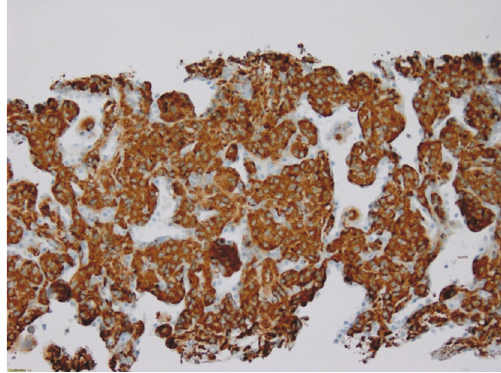
Figure 3: Neuroendocrine lung tumor biopsy staining positive for